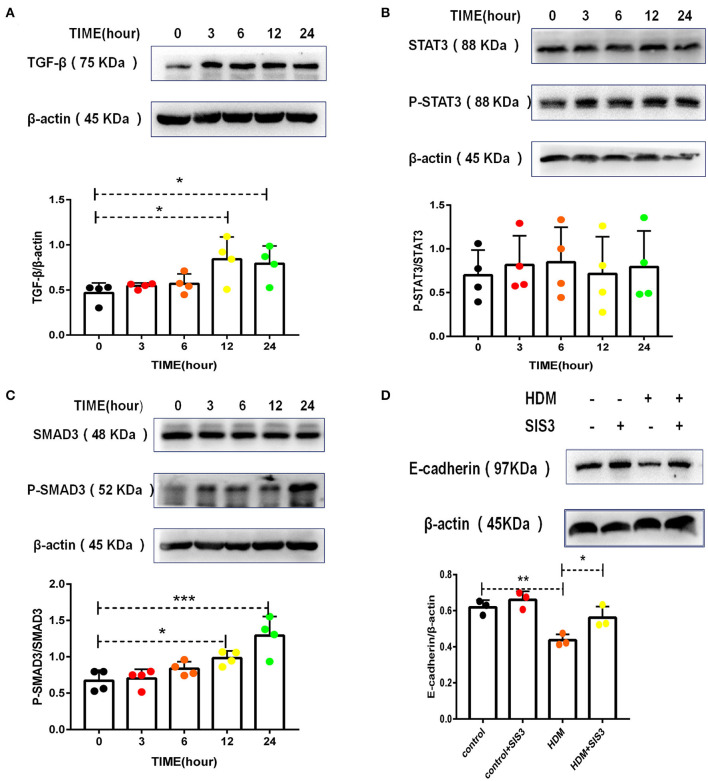
TGF-β and SMAD3 played dominant roles in HDM-treated alveolar epithelial cell EMT. (A) Western blot analysis of TGF-β expression in MLE-12 cells treated with HDM extract (100 μg/ml). (B) Western blot analysis of STAT3 expression in MLE-12 cells treated with HDM extract (100 μg/ml). (C) Western blot analysis of SMAD3 expression in MLE-12 cells treated with HDM extract. (D) Western blot analysis of E-cadherin expression in MLE-12 cells treated with HDM extract (100 μg/ml) and a SMAD3 inhibitor (SIS3, 10 μm) for 24 h. *P < 0.05; **P < 0.01;***P < 0.001.